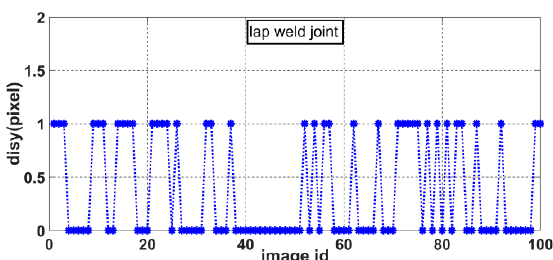
Figure 13. Distribution of dis y for lap weld joints.